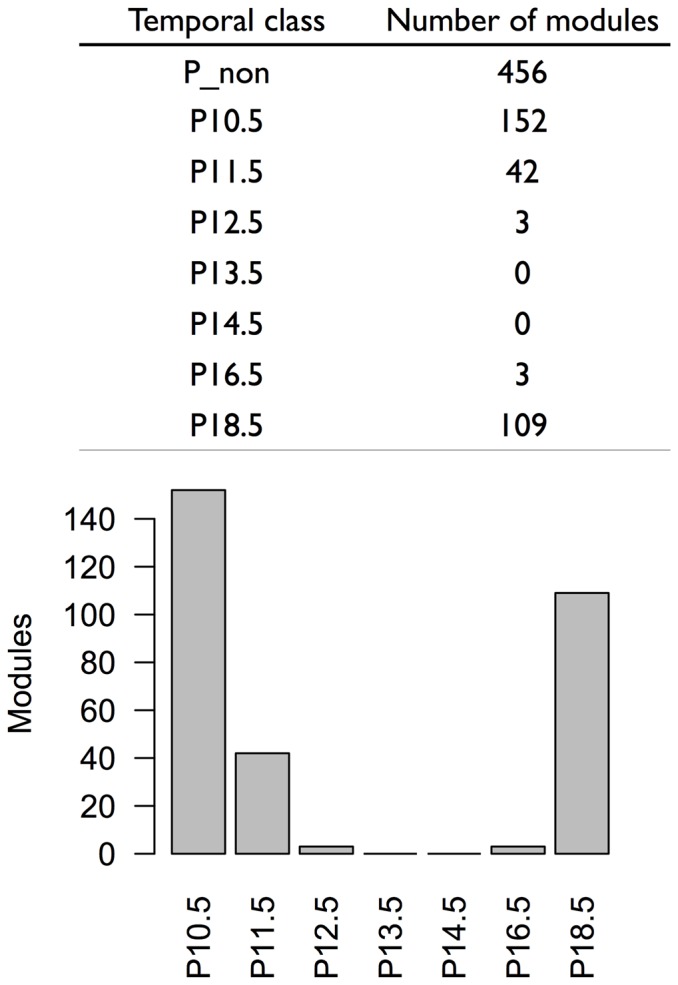
The optimal module set was classified into eight categories according to the phase specific expression in the modules.The table and bar plots summarize the classifications.